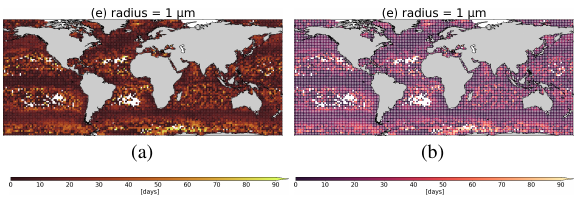
Figure 7. Inverting the colour map gives more prominence to peak-values in the plot, compared to fig. 6